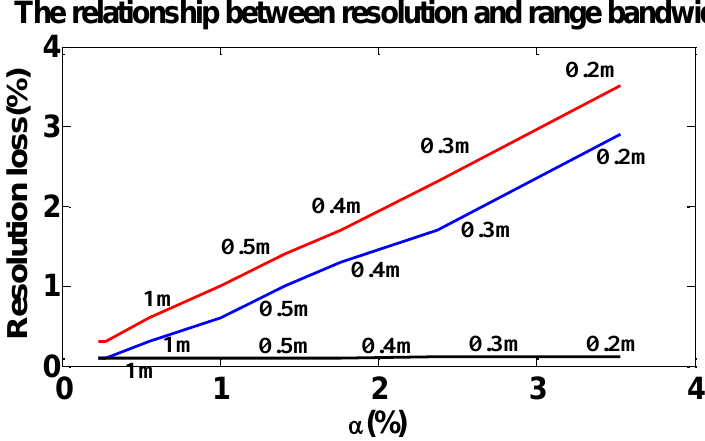
Figure 12. The relationship between PSLR loss and α . The blue line shows the PSLR loss in the azimuth direction without considering the variation of f r , the black line shows the PSLR loss in the azimuth direction with considering the variation of f r . The numbers beside the line show the two-dimensional theoretic resolution.